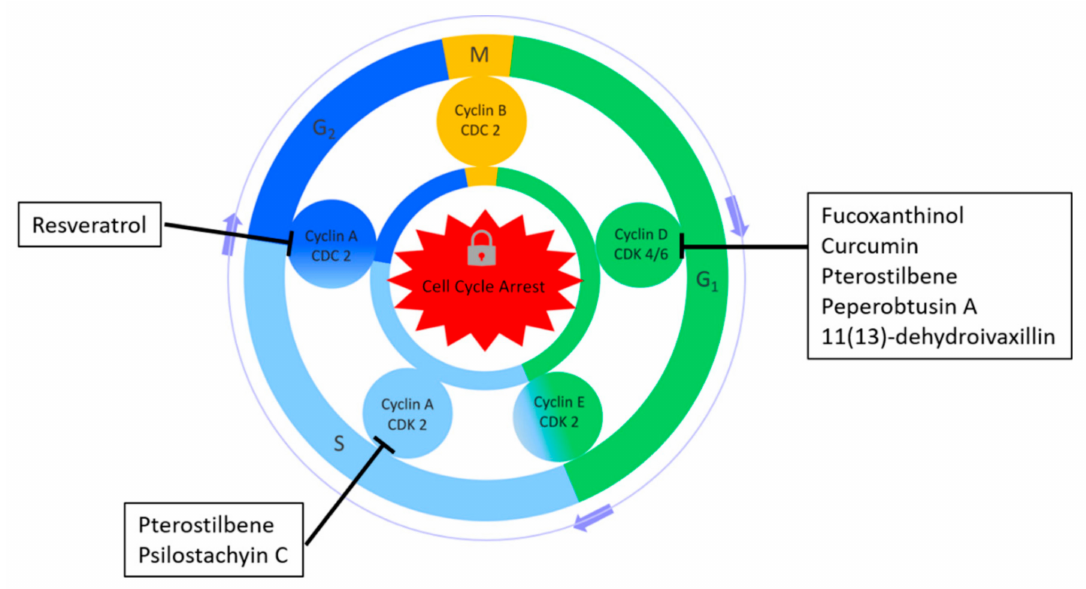
Figure 1. Schematic diagram of natural product-induced cell cycle